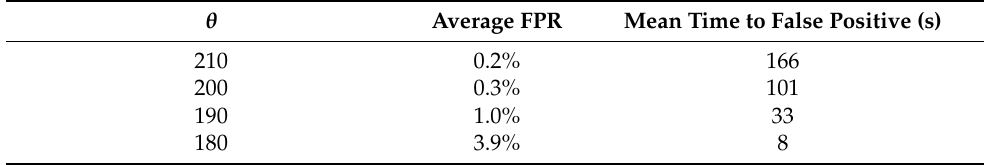
Table 7. False positive rate as a function of classification threshold.